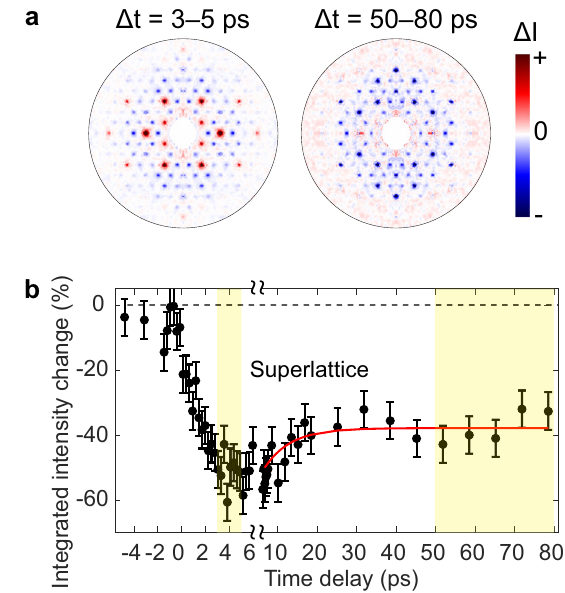
Fig. 3 Re-formation of superstructure and Debye – Waller dynamics. a Representative symmetrised difference images for early (centred around ≈ 4 ps) and late (around ≈ 65 ps) time delays. The colour scale gives the absolute diffracted intensity change ( Δ I ). For improved signal-to-noise these are calculated by averaging difference patterns over time ranges, i.e., 3 – 5 ps for early and 50 – 80 ps for late time delays. For the late time delays, all Bragg peaks exhibit a loss of intensity indicative of a Debye – Waller effect. b Dynamics of the superlattice peaks over an extended timescale. Yellow shading indicates time ranges that were averaged to generate the difference images. A partial recovery is observed, fi t with an exponential relaxation with offset (red line) with time constant τ = 6.6 ± 2.6 ps. The long-lived suppression indicates that the lattice system has thermalised at an elevated temperature. Error bars in the data indicate standard error calculated using the distribution of laser-off signals compared to the mean laser-off signal over the course of the measurement.